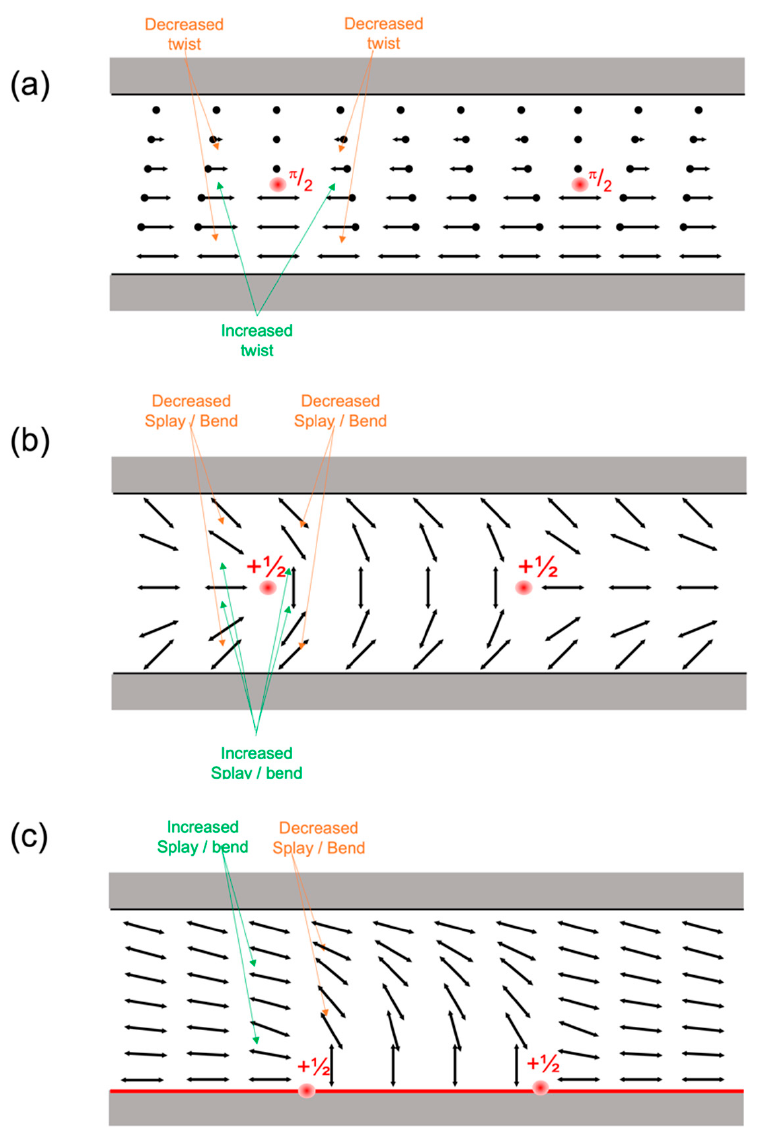
Figure 1. Defect loops of strength +½ in homotopically inequivalent states with equivalent boundary conditions: ( a ) Left- and right-handed twist; ( b ) Parallel-aligned surfaces with 45° pretilt giving horizontal and vertical states. Shown in ( c ) is a defect loop caused by a surface alignment transition, such as would occur with a zenithally bistable surface, indicated in red. Here, the upper surface has a significant pretilt so that one sign of tilt is maintained throughout the device. Without the pretilt on the upper surface, the central HAN state could also form a homotopically inequivalent state with opposing sign of tilt separated by a +½ defect loop in the bulk of the cell.